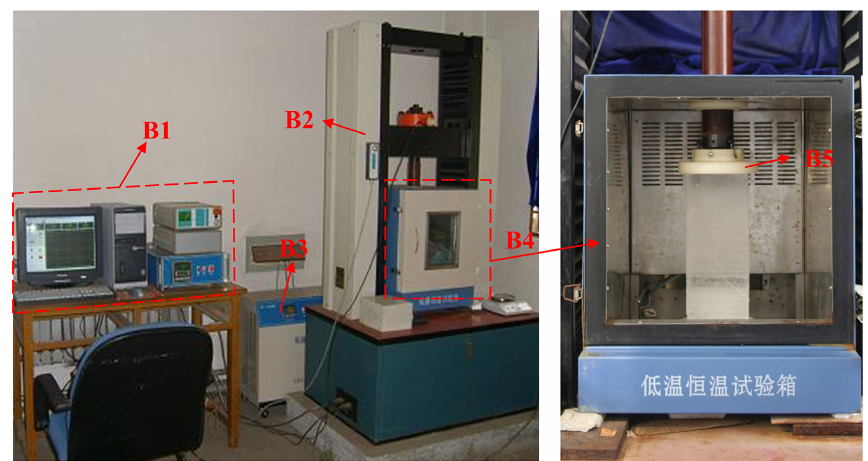
Figure 3. Experiment equipment for the uniaxial compressive strength test: (B1) control system; (B2) loading frame; (B3) refrigerating system; (B4) cryostat container; and (B5) pressing plate.